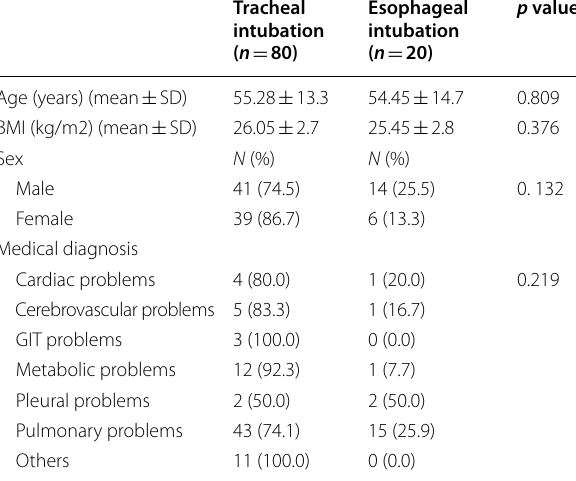
Table 1 Comparison of demographic and clinical characteristics of the study population according to the capnography